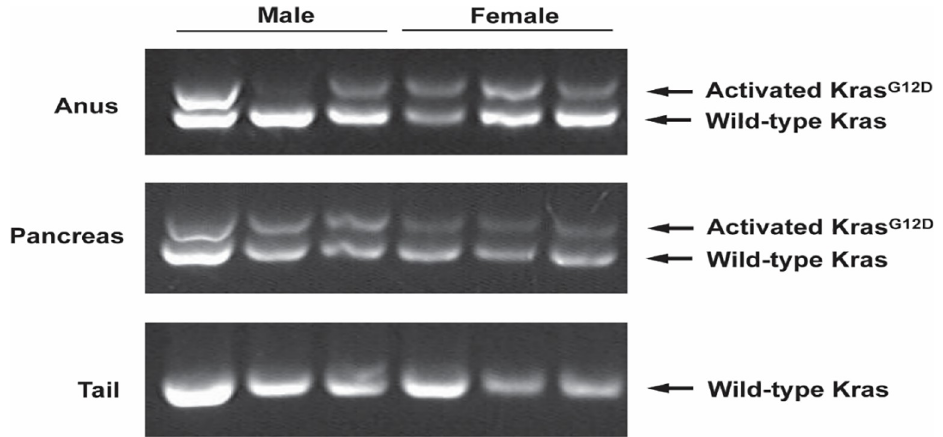
Fig 6. Activated Kras G12D is present in the anal SCC anal tumor tissue. The activated Kras G12D mutation is detected in the female anal tumor tissue, and the male anal tissues. Activated Kras refers to the successful removal of the Lox- stop-Lox codon preceding the Kras G12D . The activated mutation is present in the pancreas due to extensive Pdx1 expression, and absent in tail samples, which lack Pdx1 expression. Positive and negative controls are shown in S2 Fig.